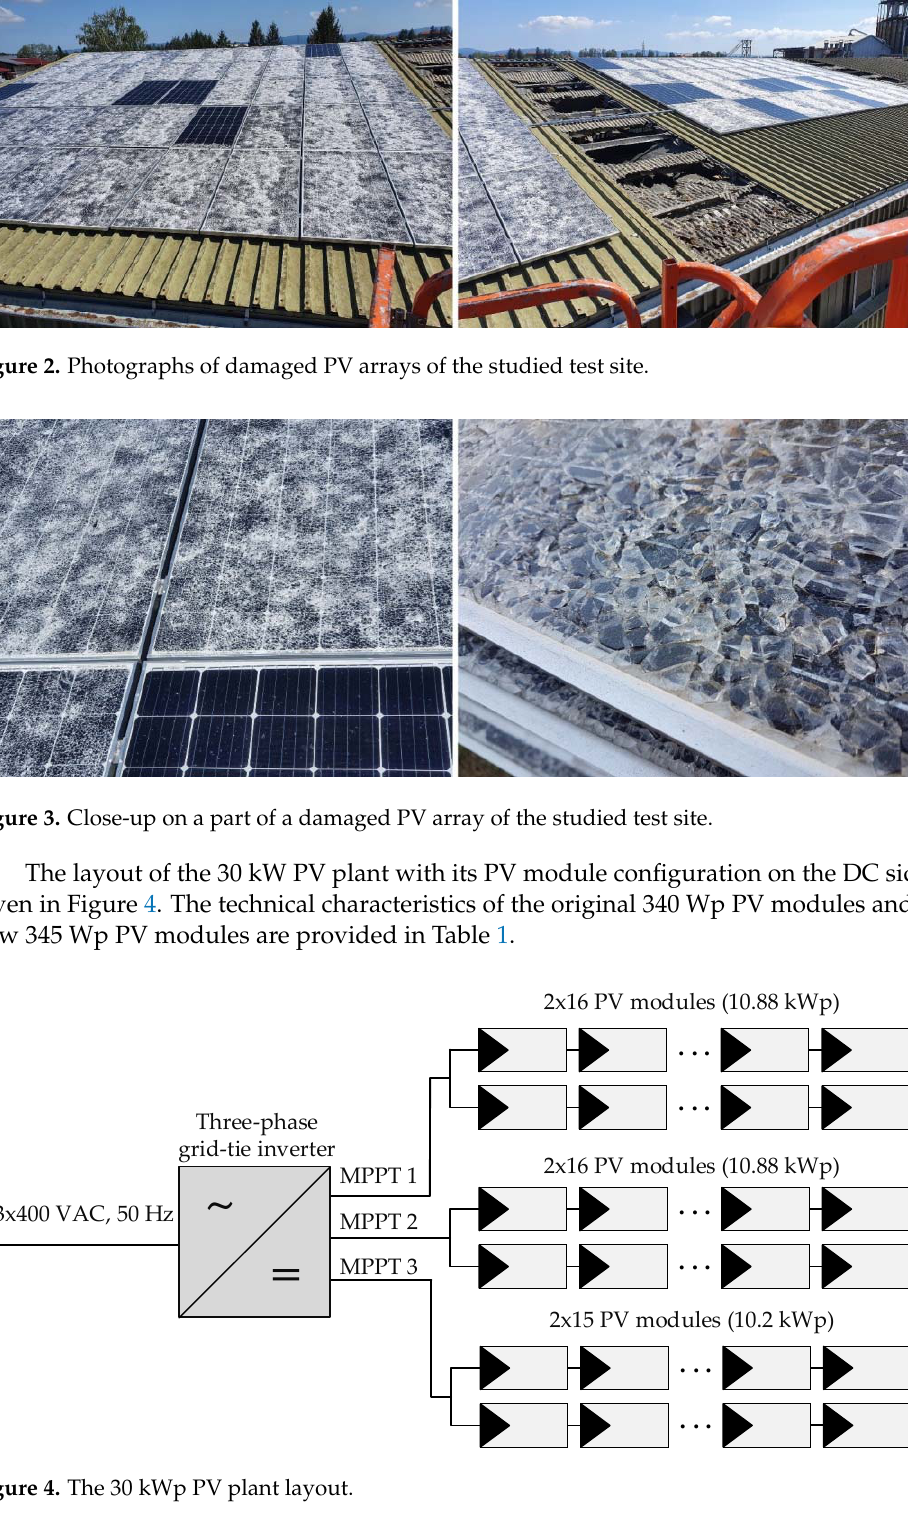
Figure 4. The 30 kWp PV plant layout. Table 1. Technical characteristics of the original 340 Wp monocrystalline silicon PV modules.